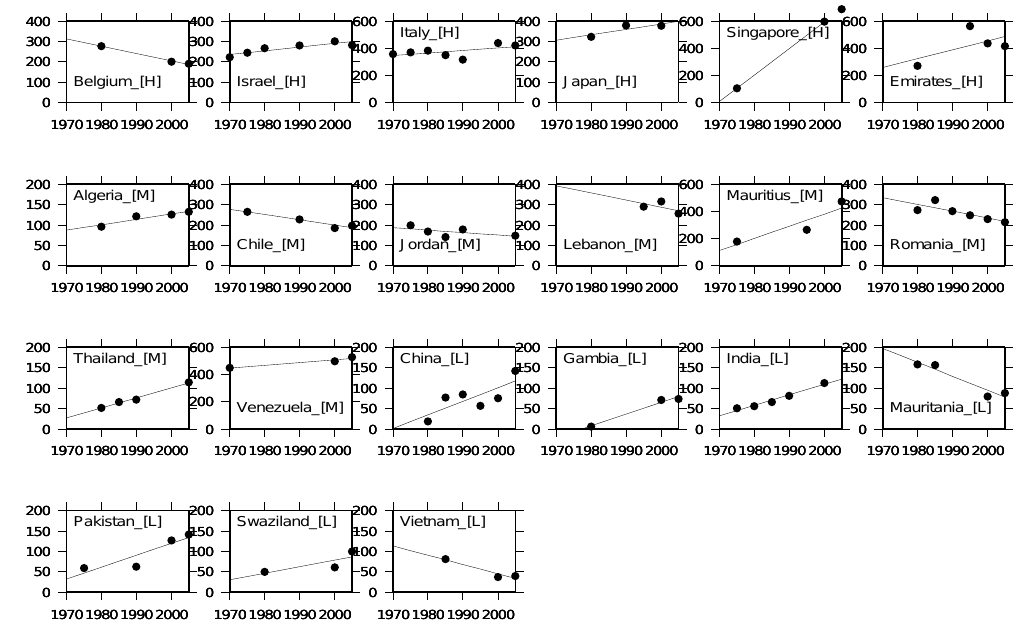
Fig. 7. Historical records of national municipal water intensity (plot) and regressions (line) (Lday − 1 person − 1 )